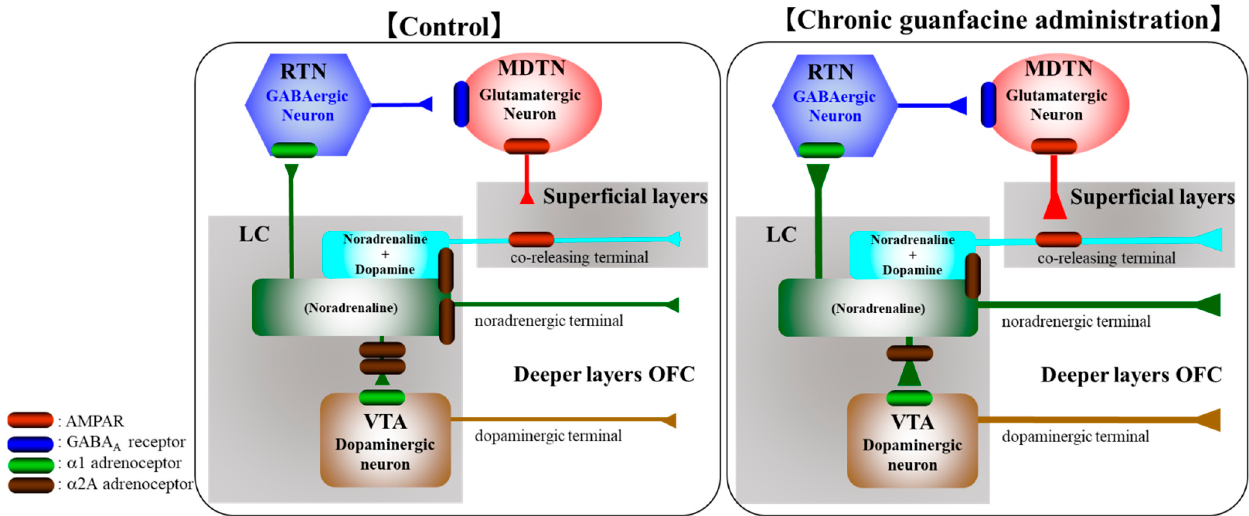
Figure 9. The proposed hypothesis for the catecholaminergic, noradrenergic, and co-releasing catecholaminergic (norepinephrine/dopamine) LC-OFC pathways, the intermediate glutamatergic LC-OFC (LC-RTN-MDTN-OFC) pathway, and the LC-VTA (LC-VTA-OFC) dopaminergic pathway. LC projects three afferents, including the selective norepinephrine releasing terminal, to deeper OFC (the direct noradrenergic pathway), RTN (a part of the intermediate glutamatergic pathway), VTA (a part of the intermediate dopaminergic pathway), and superficial OFC layers (the direct co-releasing catecholaminergic pathway). The co-releasing terminal in the OFC receives excitatory glutamatergic input from MDTN (a part of the intermediate glutamatergic pathway). The selective norepinephrine releasing terminal in RTN activates the GABAergic neuron in RTN, resulting in the inhibition of the MDTN glutamatergic neuron. The selective norepinephrine releasing terminal in the VTA activates the dopaminergic neuron in the VTA via the α 1 adrenoceptor, resulting in increased dopamine release in the OFC. The acute activation of the postsynaptic/somatodendritic α 2A adrenoceptor in the LC by guanfacine reduces noradrenergic transmission in noradrenergic LC-OFC and LC-VTA pathways and catecholaminergic transmission in the co-releasing catecholaminergic LC-OFC pathway. Contrary to the acute effect of guanfacine, chronic guanfacine administration enhances catecholaminergic transmission in both noradrenergic LC-OFC and LC-VTA pathways and catecholaminergic LC-OFC pathways via the downregulation of inhibitory α 2A adrenoceptors.